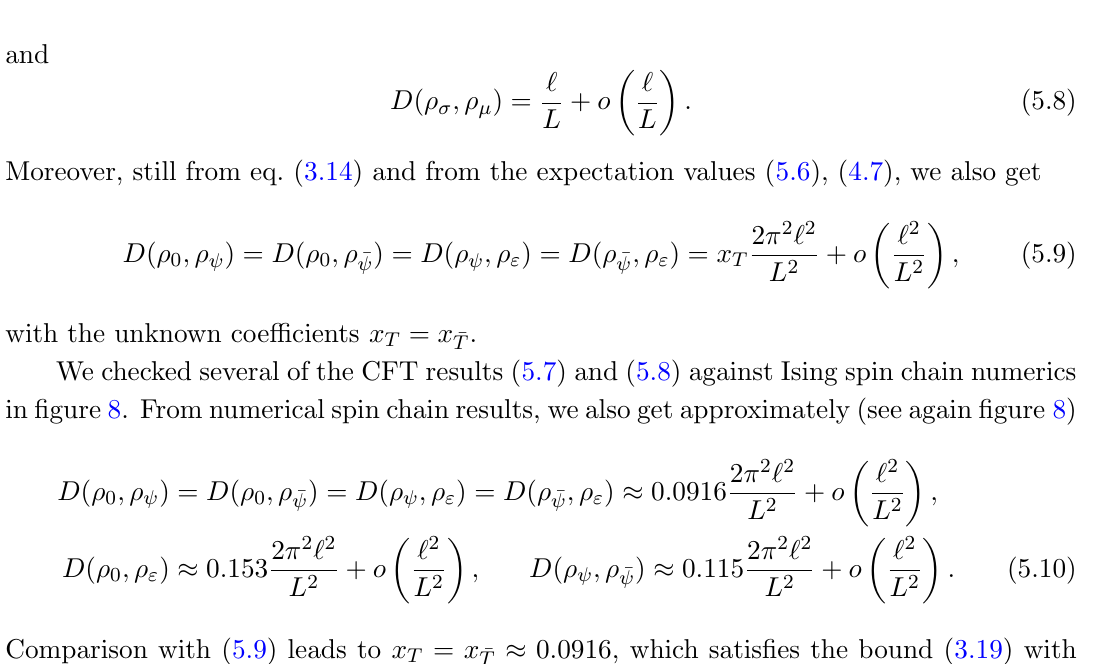
Figure 8 . Trace distance D ( (cid:26); (cid:27) ) among the RDMs in di(cid:11)erent low-lying states as a function of the ratio between the subsystem ‘ and the system size L in the free fermion theory. The solid lines denote the leading order CFT prediction in the limit of short interval, eqs. (5.7) and (5.8). The symbols joined by dashed lines represent numerical data, with di(cid:11)erent symbols corresponding to di(cid:11)erent L . Di(cid:11)erent colours correspond to di(cid:11)erent pairs of states with \gs" denoting the ground